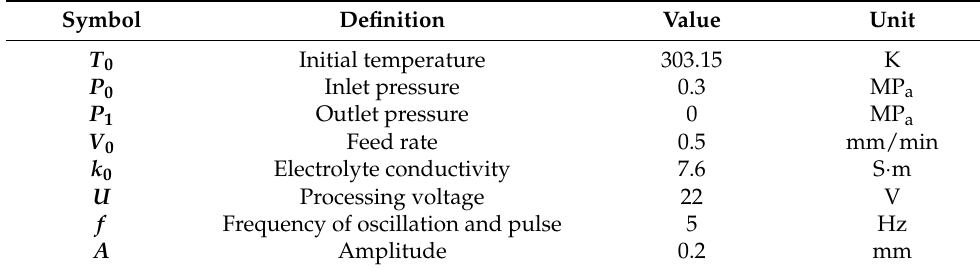
( c ) Figure 6. Distributions of electrolyte velocity over time; ( a ) t = T /4. The nearest cathode position to the anode, the maximum flow is 0.179 L/s; ( b ) t = T /2. Cathode at the middle position, the maximum flow increases to 0.219 L/s; ( c ) t = 3 T /4. Cathode at its farthest position to the anode, the maximum flow reaches 0.256 L/s. The temperature distributions in the machining area in a unit cycle are obtained through transient simulation, as shown in Figure 7. The heat generated in the ECM pro- cess gradually accumulates and the temperature in the machining gap gradually increases along the flow direction. Due to the small machining gap and increasing machining depth, the heat is difficult to eliminate. The temperature is 303 K in the inlet wall and increases to 308 K to the side of the outlet at T /4, as shown in Figure 7a. Figure 7b,c indicate that